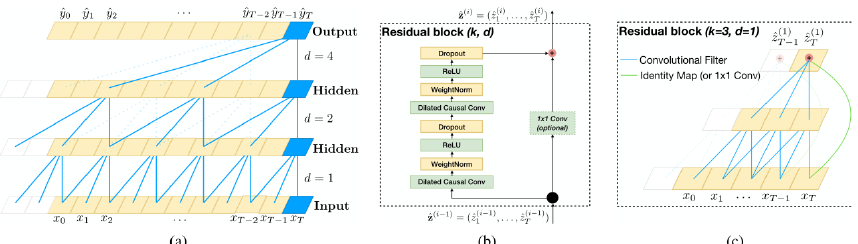
Figure 7. A structure diagram of a generic TCN network: ( a ) the expansion coefficients d = 1, 2 and 4 and the dilated convolution with a kernel size k = 3 enable the receptive field to cover all of the values in the input sequence; ( b ) the TCN residual block (when residual inputs and outputs have different dimensions, a 1 × 1 convolution is added); ( c ) an example of residual connections (the blue line shows the convolution kernel in the residual function and the green line represents the identity